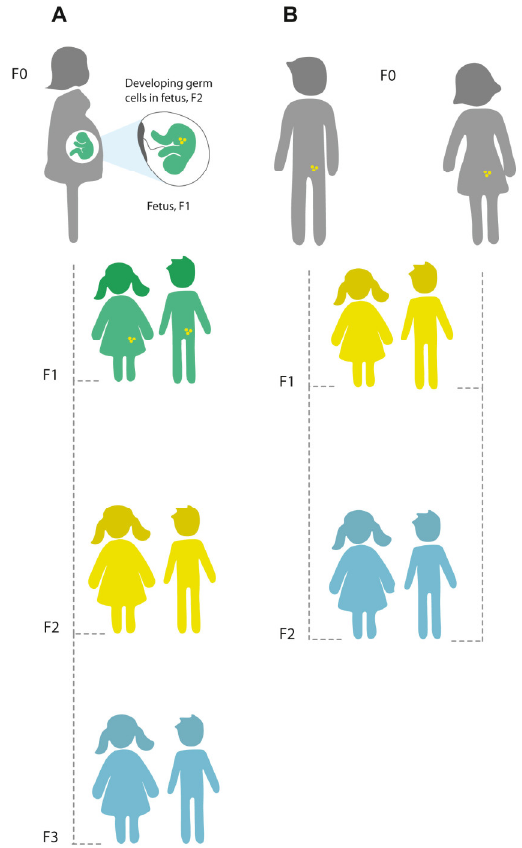
Figure 2. Principles of intergenerational and transgenerational epigenetic inheritance. ( A ) If a pregnant woman (F0) is exposed to an environmental stressor, her son or daughter (F1; green), and his or her germ cells that will form the F2 generation (yellow) are also directly exposed, and this might result in intergenerational effects. The third generation (F3; blue) is the first generation that could represent transgenerational epigenetic inheritance. ( B ) If a man or a woman (F0) and their germ cells to the F1 generation (yellow) are directly exposed to an environmental stressor, the F2 offspring (blue) is the first generation that could represent transgenerational epigenetic inheritance. (Figure reproduced from [28] under the terms of Creative Commons Attribution